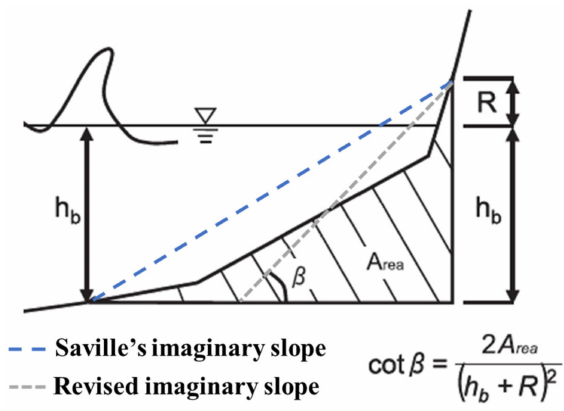
Figure 2. Imaginary slope of foreshore and seawall scheme used in the Mase formulas application (adapted from